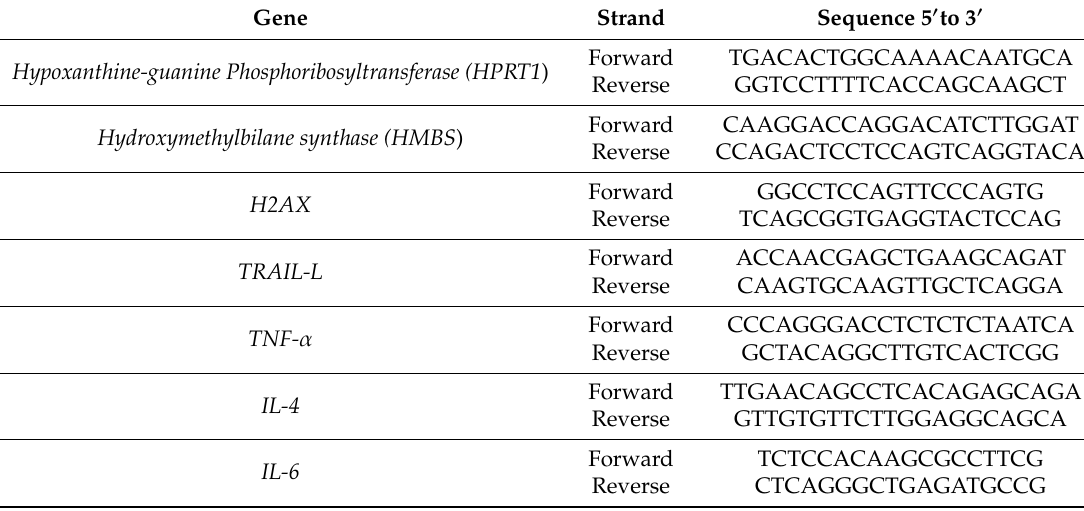
Table 1. Primer sequences used for